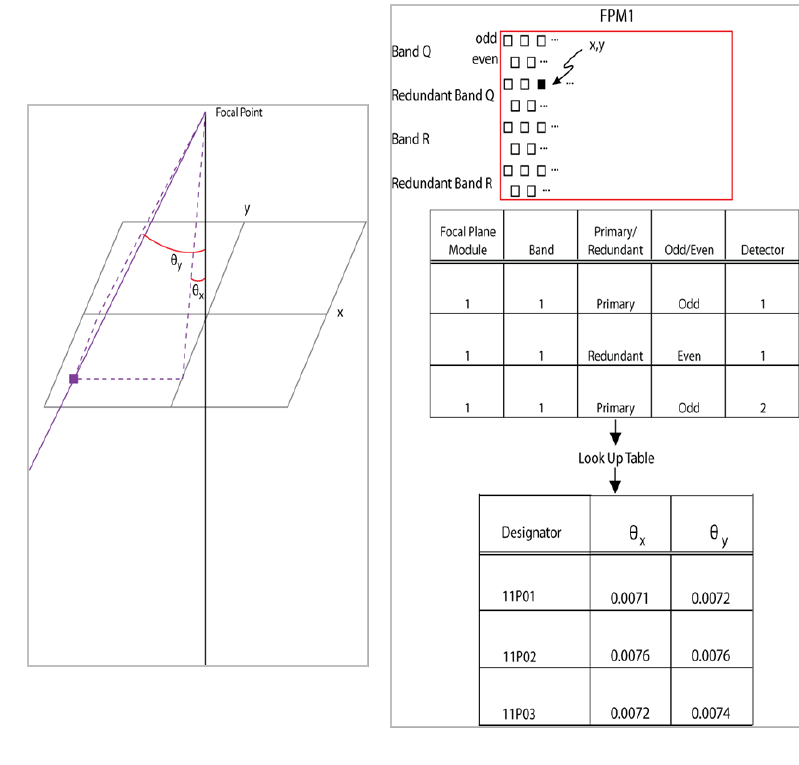
Figure 3. Illustration of angle-angle lines of sight relative to the optical axis for each detector element (left). The complexity of the focal plane and how this is converted to an angle-angle look-up table (in this case for OLI) are shown at the